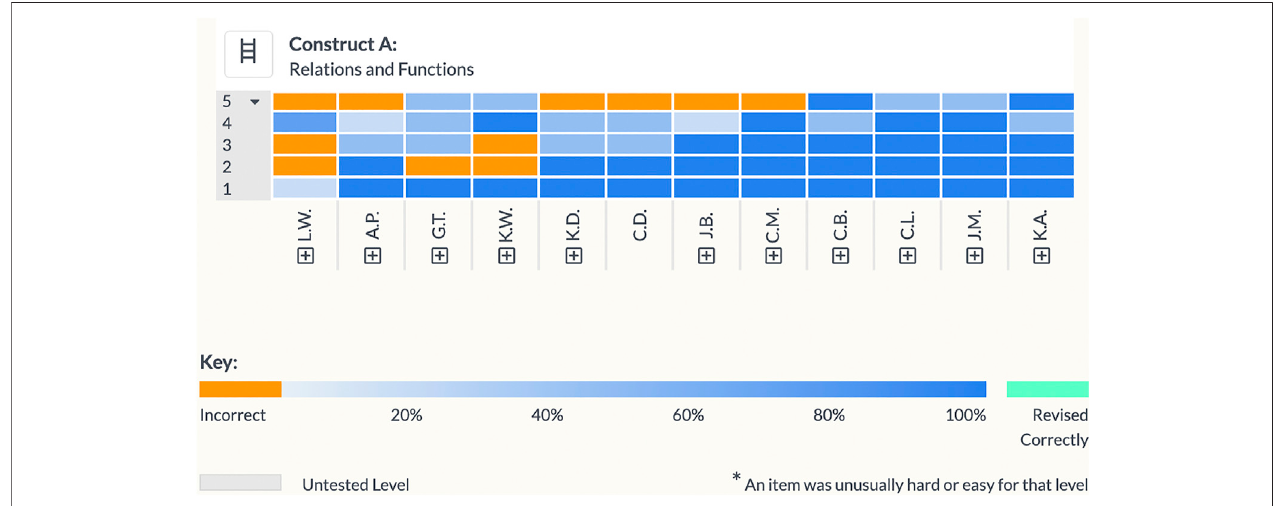
FIGURE 6 | Class report: heatmap for the Relations and Functions